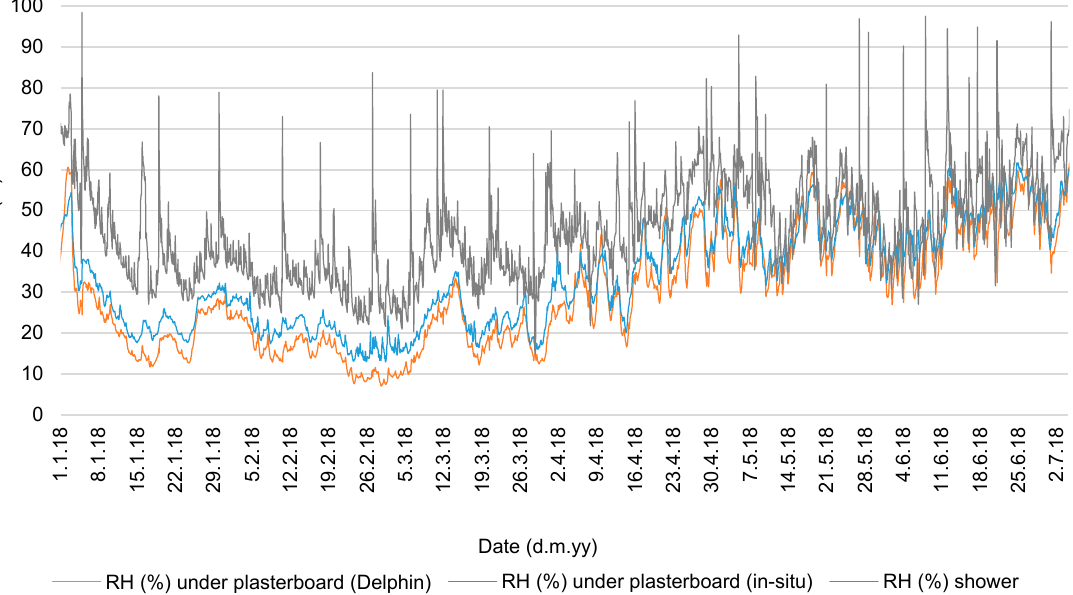
Figure 15. The temperature within the living room wall between dolomite and the insulation layers: measured T (blue line), simulated T (orange line), indoor T (grey line), and outdoor T (green line). The bathroom RH between the insulation layer and vapor barrier never exceeds the critical level of 80%, mostly staying below 40% during the cold season and below 70% during the spring and summer (see Figure 16).